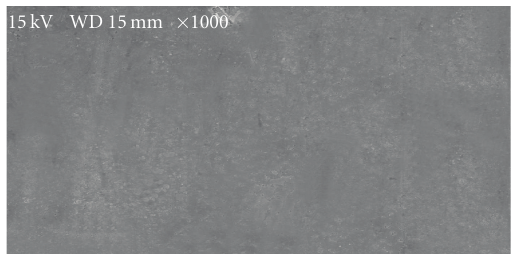
Figure 12: SEM Photograph of mild steel immersed in 1N HCl solution containing an optimum conc. (10% v/v) of Solanum trilobatum .